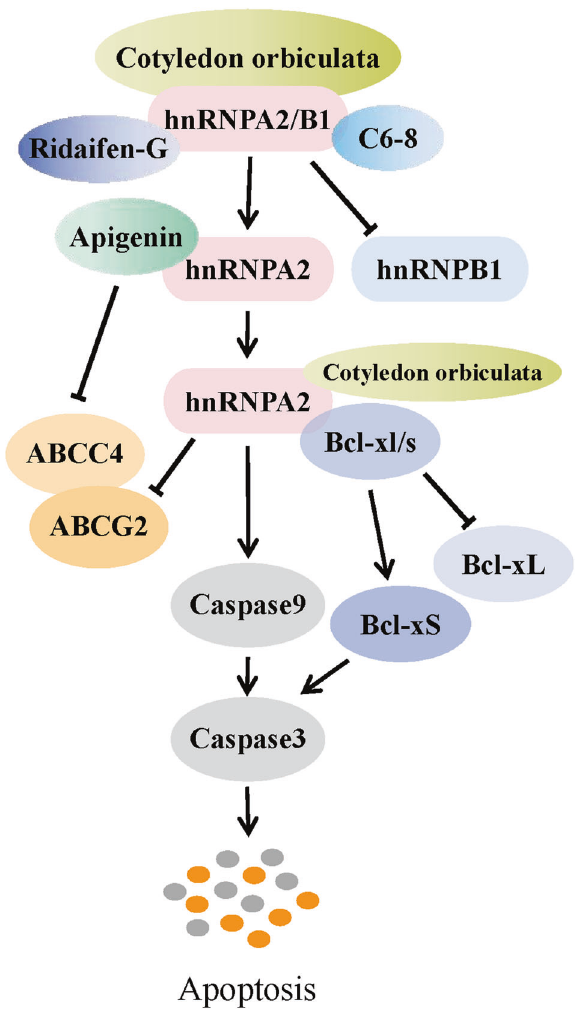
Fig. 5 Therapeutic exploration targeting hnRNPA2/B1. The potential druggability of hnRNPA2/B1 was successively discov- ered. Cotyledon orbiculata could induce cancer cell apoptosis by splicing hnRNPA2/B1 from B1 to A2 isoform. Apigenin could in fl uence chemosensitivity and apoptosis of cancer cells by regulating hnRNPA2. In addition, hnRNPA2/B1 was identi fi ed as a direct target of C6-8 and